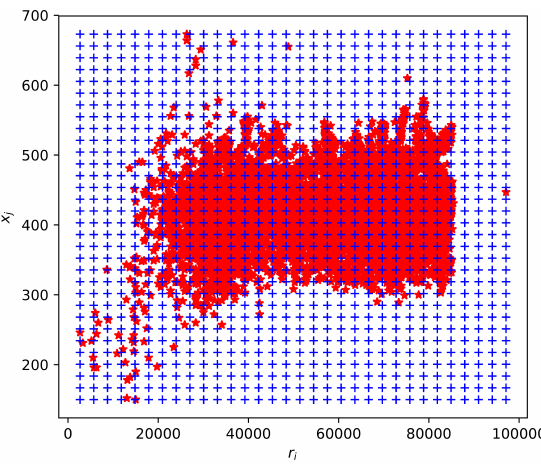
Figure 3. Data and 32 × 32 grid for